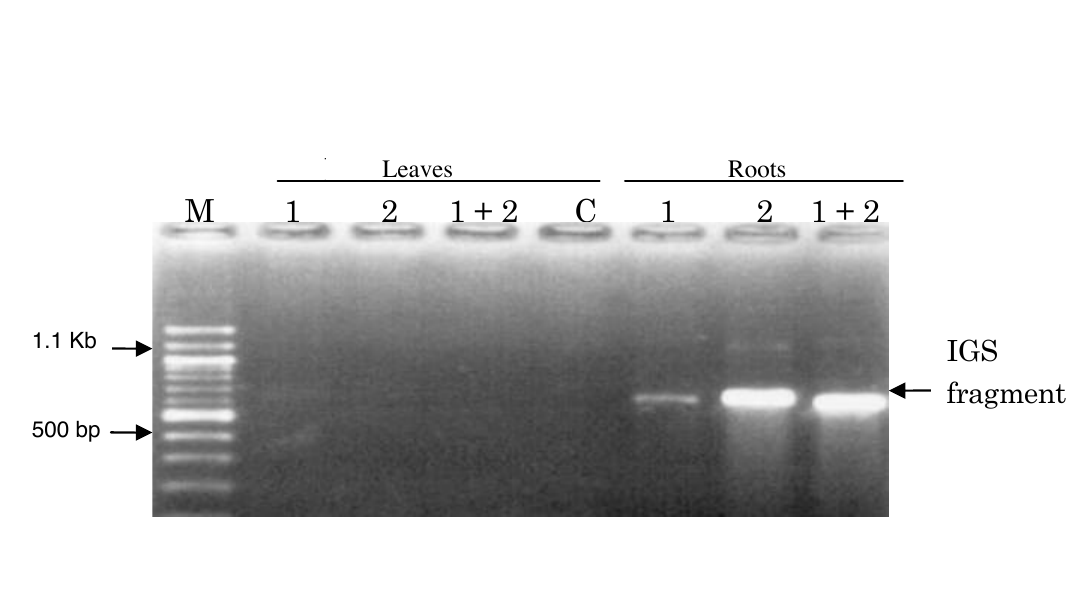
Fig. 5. PCR products with the IGS region primers using as templates DNA extracted from the roots and leaves of tomato cv. Momotaro 24 days after inoculation. Lanes, M, 100-bp DNA marker; gDNA, fungal genomic DNA extracted from Fusarium oxysporum f. sp. lycopersici race 1, and race 2 was used as a template; roots, total DNA extracted from tomato cv. Momotaro roots inoculated singly with race 1, and with race 2, and jointly with races 1+2, was used as a template; leaves, total DNA extracted from tomato cv. Momotaro roots inoculated singly with race 1, and with race 2, and jointly with races 1+2 was used as a